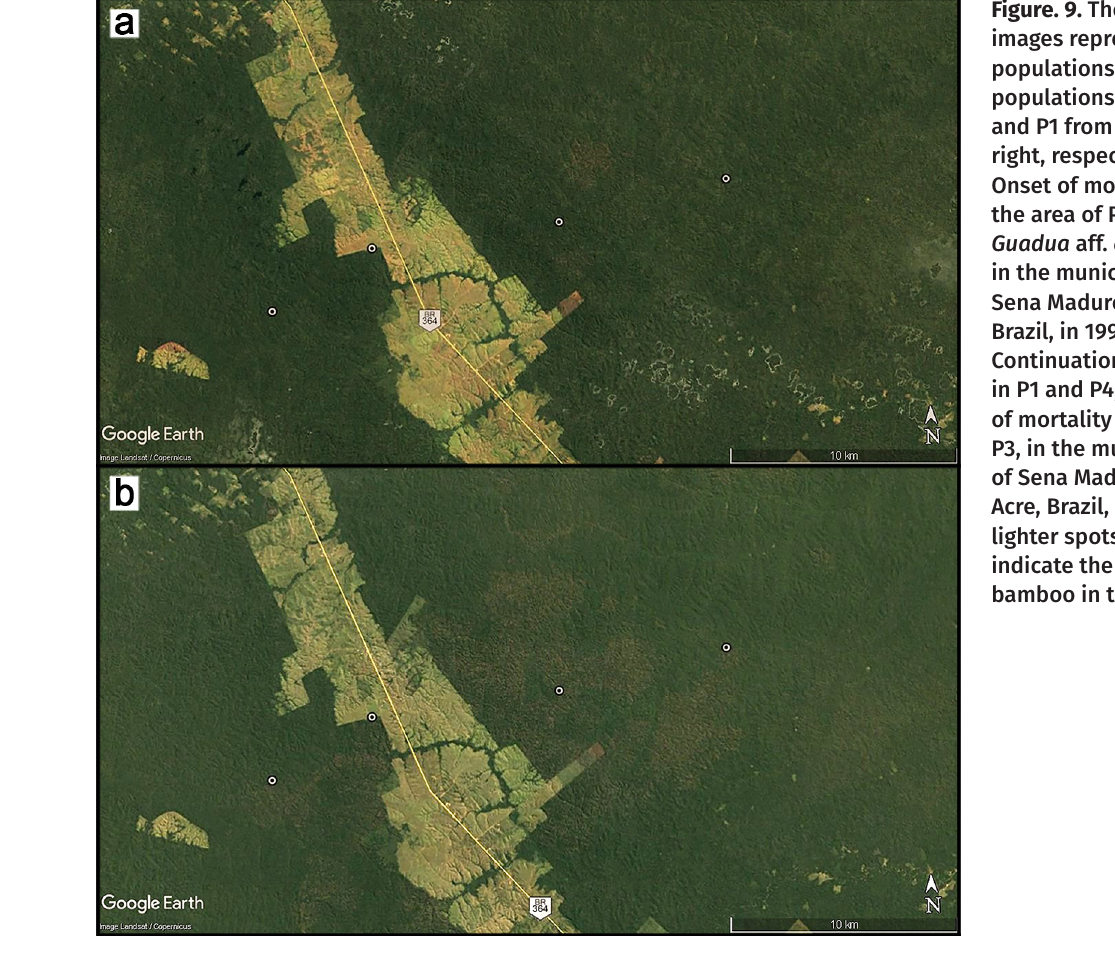
Figure. 9. The dots in the images represent the populations, showing populations P2, P3, P4 and P1 from left to the right, respectively. (a) Onset of mortality in the area of P1 and P4 of